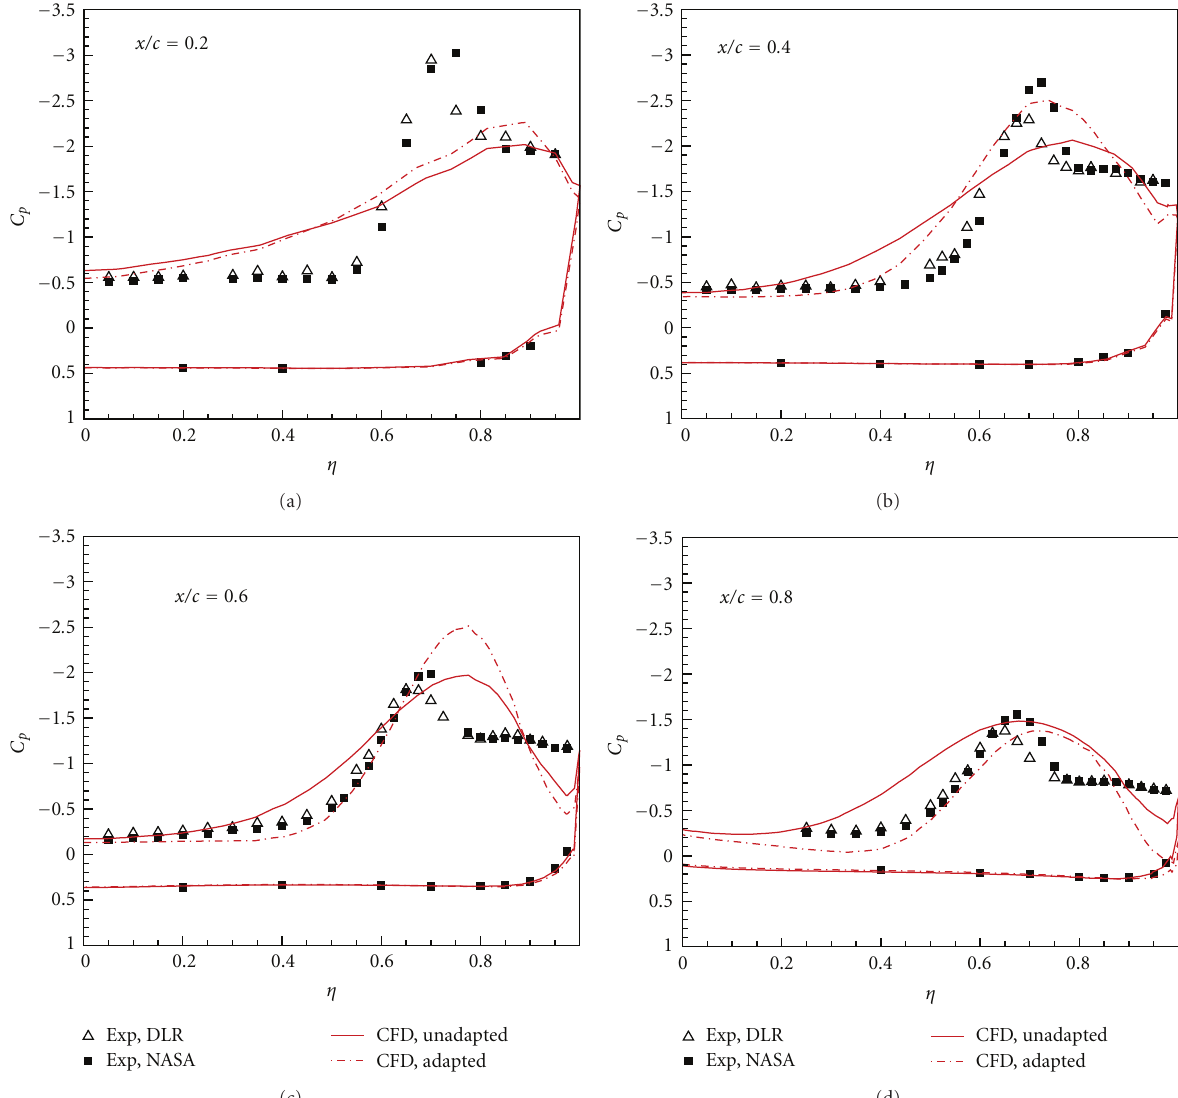
Figure 11: Comparisons of spanwise pressure coe ffi cient distributions for delta wing with sharp leading edge between before and after mesh